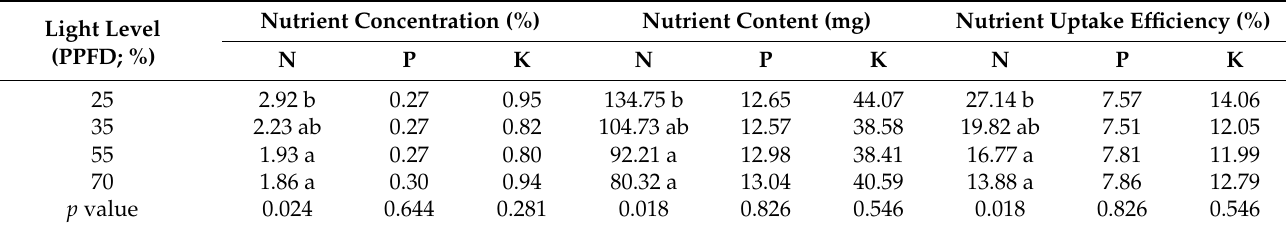
Table 4. Statistical significance and mean values ( n = 4) in variables related to nutrient status of Enterolobium cyclocarpum plants exposed to varying photosynthetic photon flux density (PPFD) levels. For a particular nutrient in the same variable, means with a letter in common are not significantly different ( p > 0.05) according to Fisher’s LSD test. ( α = 0.05).